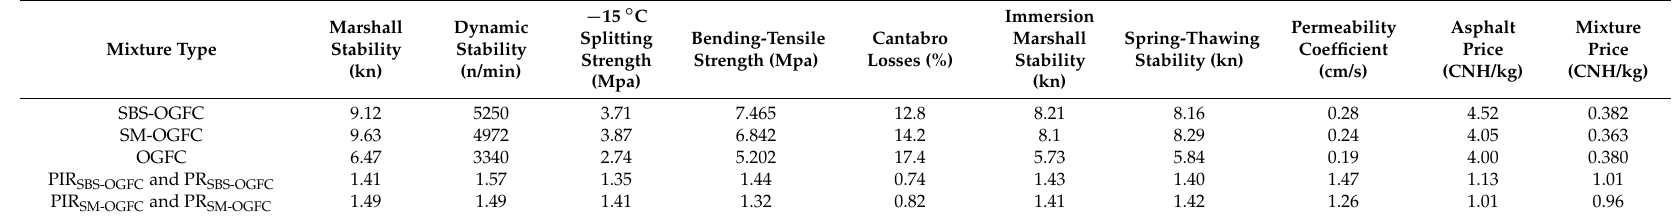
Table 11. Economic benefit